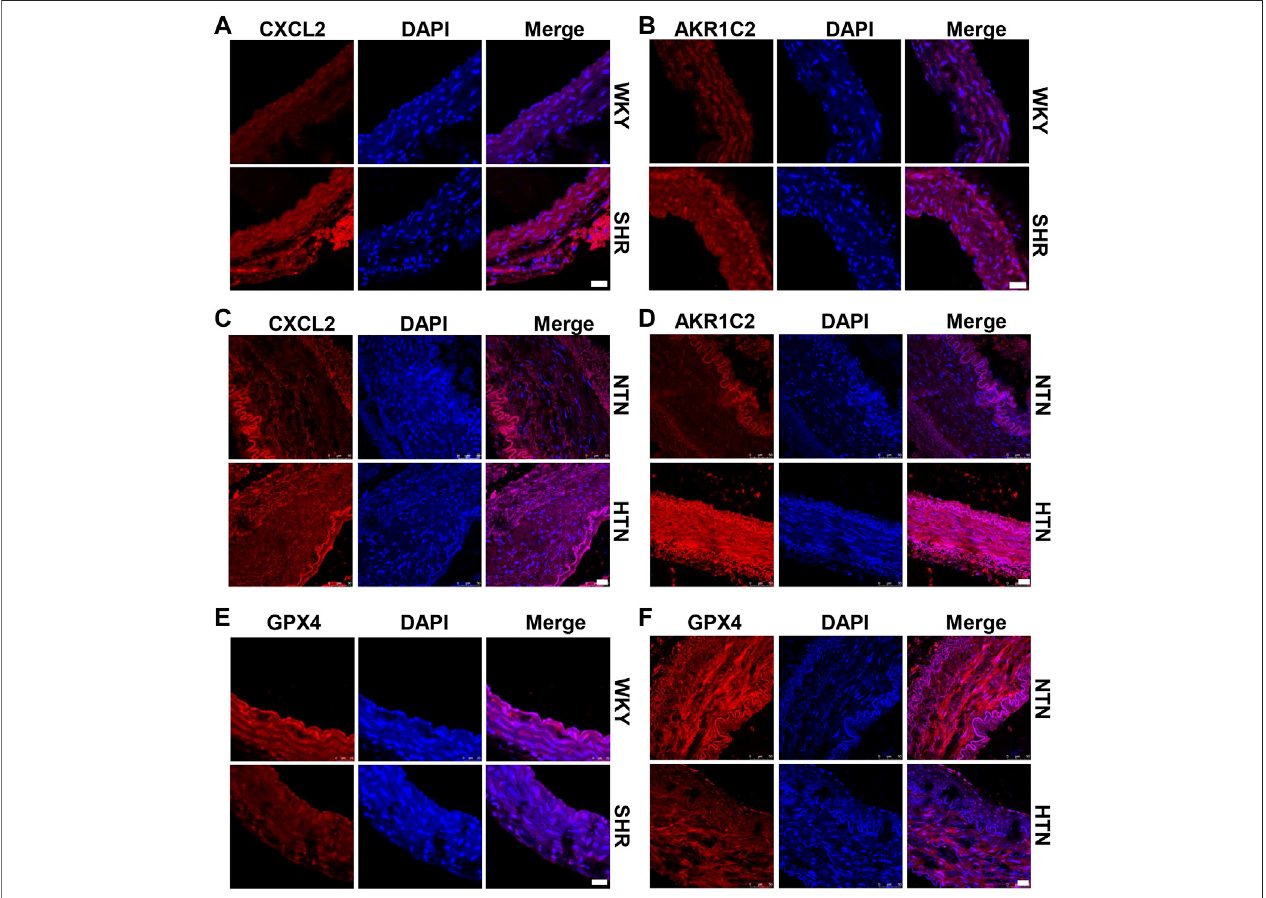
FIGURE1| GPX4expressionpositivelycorrelatedwiththeVSMC-speci fi cphenotypeinSHRandhypertensivepatients.Immuno fl uorescentstainingofCXCL2 (A) and AKR1C2 (B) inthearterialmediaofSHR.Immuno fl uorescenceofCXCL2 (C) and AKR1C2 (D) onparaf fi n-embeddedhumannormotension(NTN)andhypertension (HTN) internal mammary arteries. The GPX4 expression was detected by immuno fl uorescent staining in SHR (E) and human hypertensive patients (F) . Nuclei were counterstained with Hoechst. Scale bar = 25 µM.